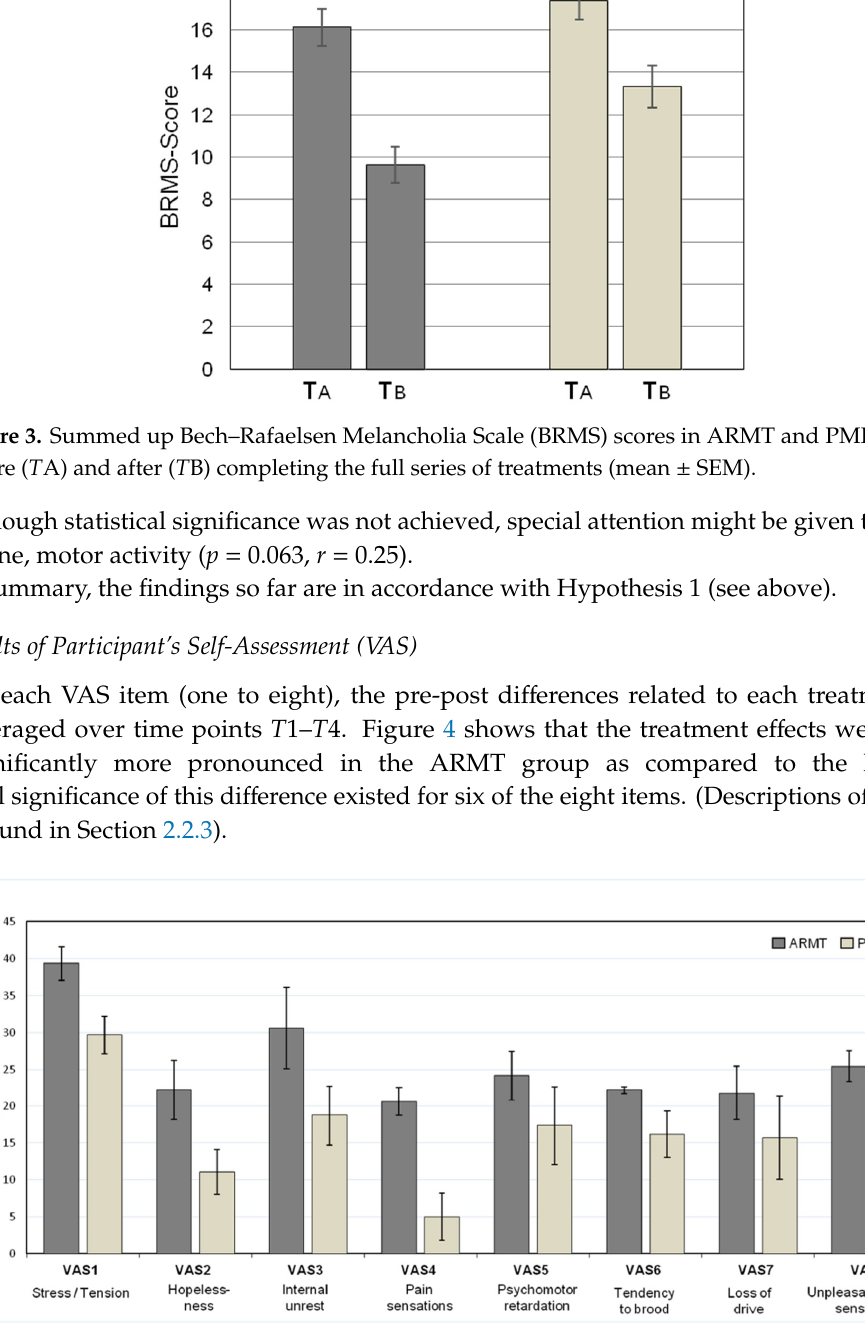
Figure 4. Averaged differences (± SD) of individual pre-/post-treatment visual analogue scale (VAS) values over total study period ( T 1 – T 4 ).